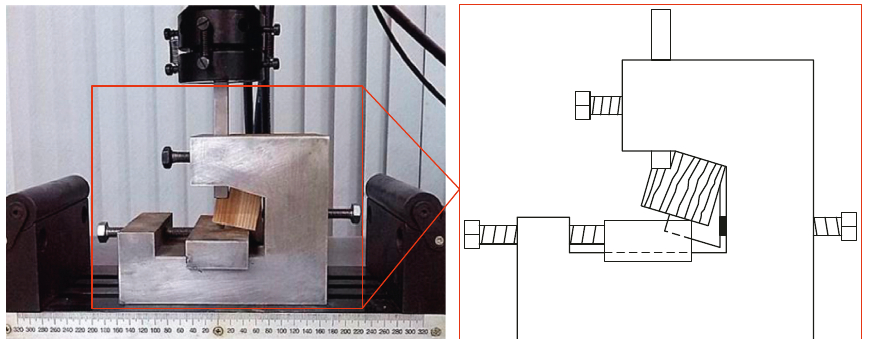
Figure 6: Load machine and ancillary equipment for the shearing test.